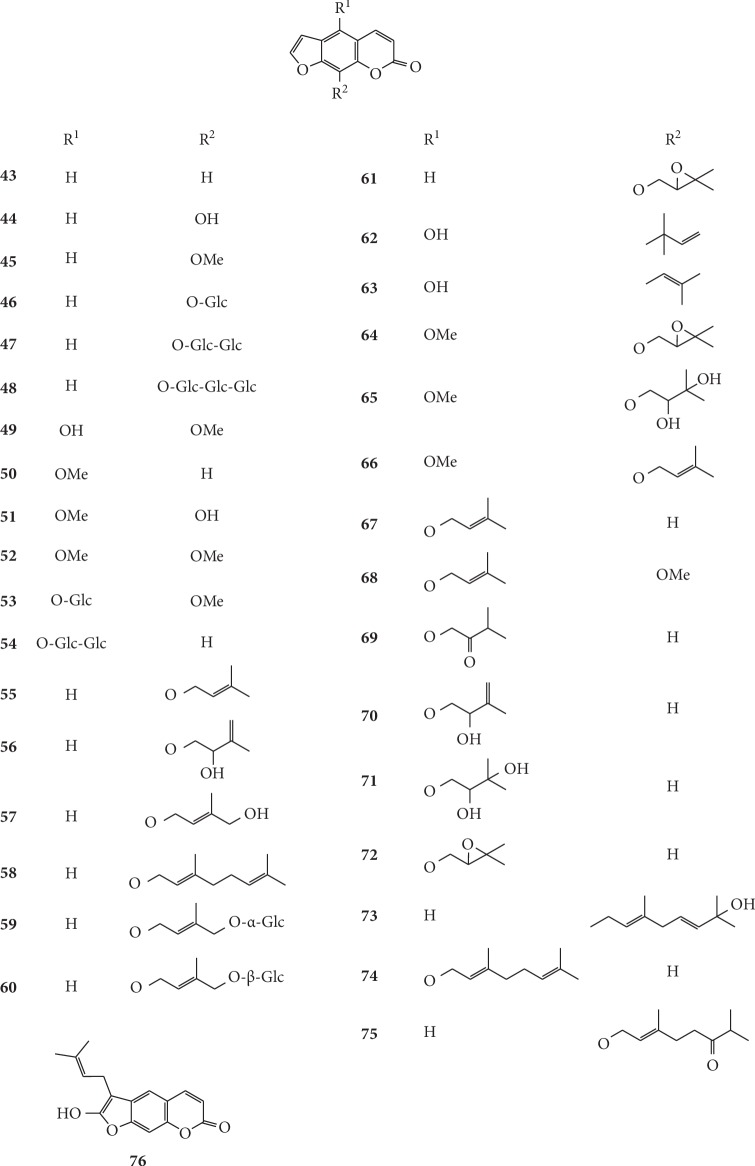
Structures of furanocoumarins in G. littoralis.